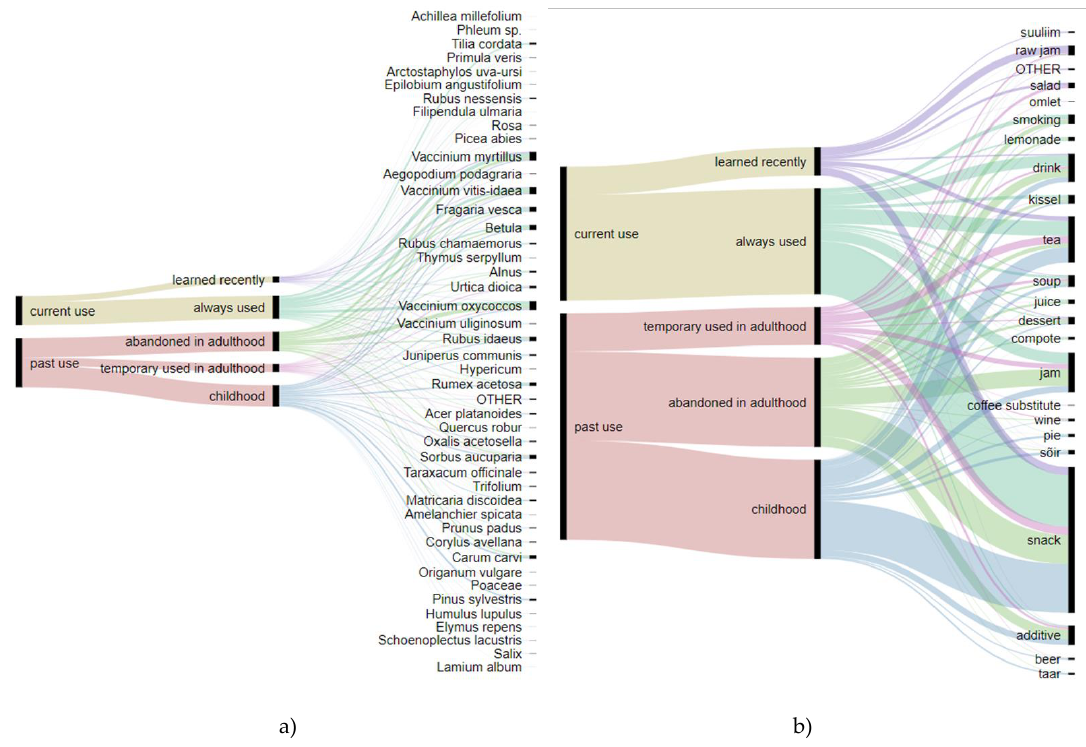
Figure 3. Alluvial diagrams outlining ( a ) taxa used and ( b ) food made depending on the time of